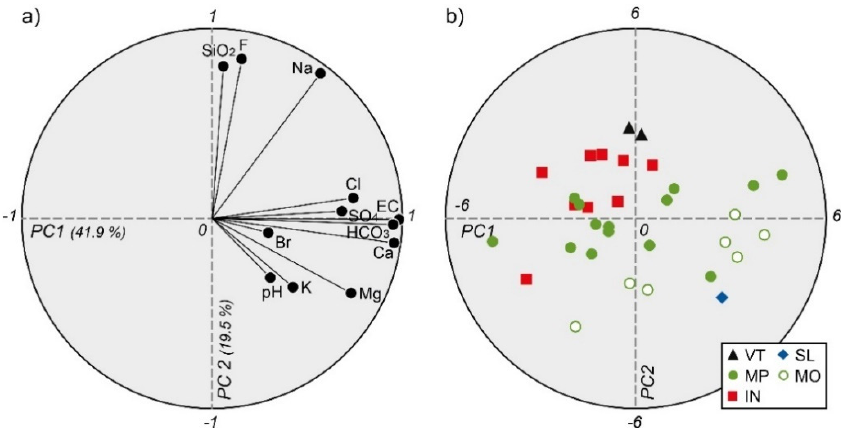
Figure 3. Principal component analysis (PCA) results for Ca-HCO 3 -type bottled water ( n = 33), showing ( a ) loadings for physicochemical parameters ( p = 11) and ( b ) scores for each sample. In ( b ), water samples are grouped into geological units around the borehole (see also Table 1): VT = Tertiary to Cretaceous volcanic rocks; SL = Cambro–Ordovician rocks of Great Limestone group; MP and MO = metamorphic rocks; IN = intrusive rocks. Table 2. Statistical summary of major physicochemical parameters of Ca-HCO 3 -type bottled water in South Korea ( n = 33). WHO and South Korean drinking water quality standards are also